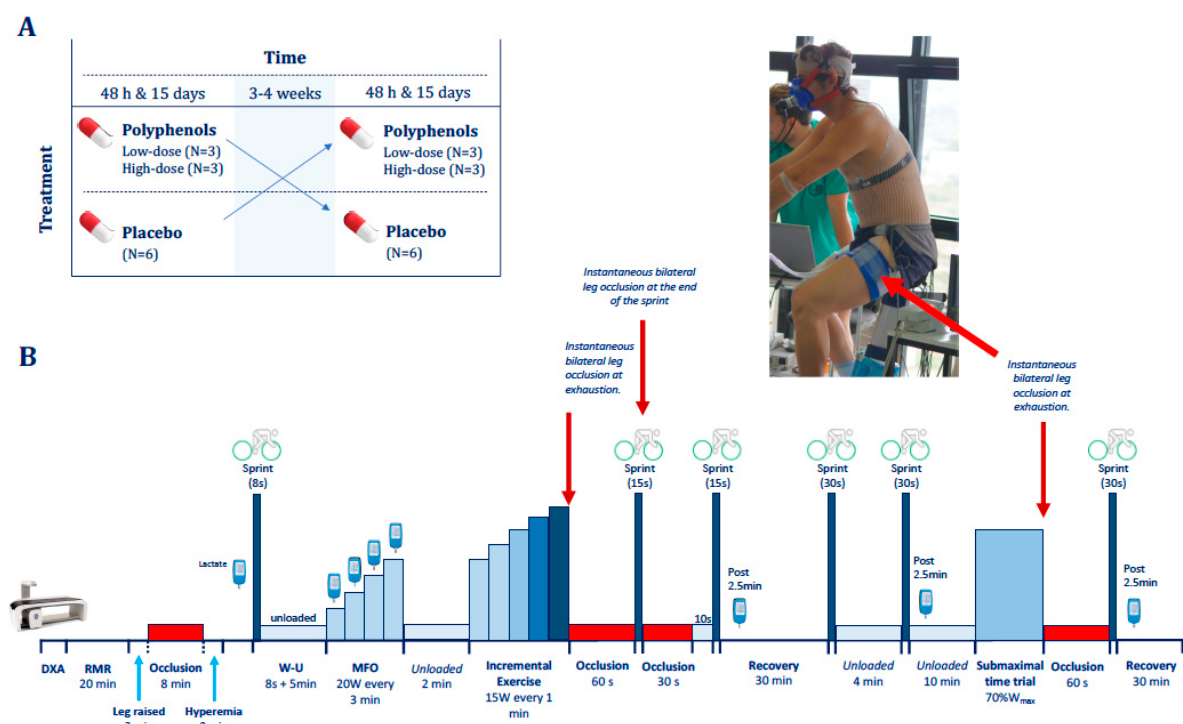
Figure 1. Experimental protocol. ( A ) Botanical extracts of mangiferin and luteolin were administered during following a double-blind, counterbalanced crossover design. ( B ) Exercise protocol. Forty-eight hours after the start of the supplementation subjects reported to the laboratory and their body composition and resting metabolic rate (RMR) were determined. The exercise protocol started with a warming-up 8 s isokinetic sprint on a cycle ergometer, followed by 5 min of unloaded pedaling ( ∼ 40 rpm) and an incremental exercise test (20 W/3 min) to determine their maximal fat oxidation (MFO). This was followed by 2 min of unloaded pedaling and an incremental exercise test (15 W/min) until exhaustion to determine the VO 2 max. At exhaustion, ischemia was applied to both legs for 60 s. Then the cuff was released, and the subjects sprinted maximally for 15 s. At the end of the 15 s sprint, a second occlusion was started for 30 s, which was followed by 10 s of free circulation with unloaded pedaling and a second 15 s sprint. Then the subjects rested for 30 min and after that performed two 30 s Wingate tests interspaced by 4 min of unloaded pedaling. After 10 min of unloaded pedaling a submaximal constant-intensity time trial to exhaustion was started at 70% of the intensity reached at exhaustion in the incremental exercise test (Wmax). At the end of the endurance test, ischemia was instantaneously applied for 60 s, followed by the last Wingate test with open circulation and 30 min of recovery on a stretcher. Blood samples for blood lactate assessment were obtained as indicated in the figure. This protocol was repeated after 15 days of